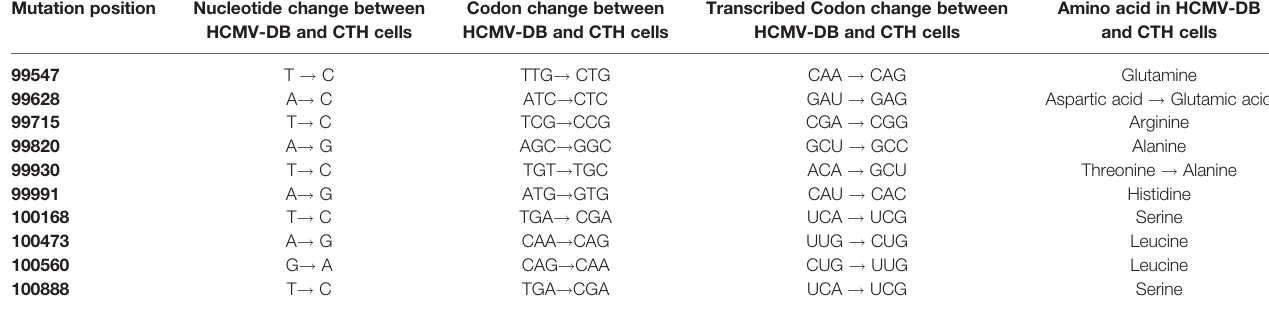
TABLE 2 | Detection of nucleotide point mutations in the UL69 gene present in CTH cells compared to the HCMV-DB. Mutation position Nucleotide change between Codon change between Transcribed Codon change between Amino acid in HCMV-DB HCMV-DB and CTH cells HCMV-DB and CTH cells HCMV-DB and CTH cells and CTH cells